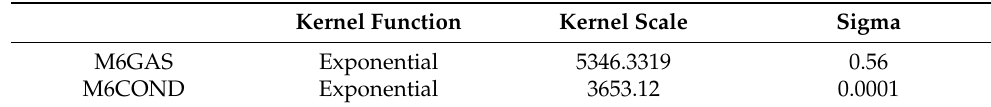
Table 6. Hyperparameters for GPR model.